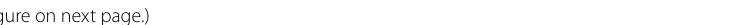
figure(See figure on next Fig. 1 Map of the focal area of the 2011 Tohoku-Oki earthquake. Focal mechanisms represent the mainshock (red), the aftershock in the off-Ibaraki (blue, hereafter “Ibaraki-Oki EQ”), and the aftershock in the off Iwate (green, hereafter “Iwate-Oki EQ”) estimated by NIED. Red squares denote the GEONET sites used for the primary analysis. Blue squares are the additional sites used for the analysis of the Iwate-Oki EQ. Gray rectangles show the assumed fault planes. Black and gray dotted lines indicate trench axis and the depth of the plate interface, respectively. Two red arrows in the bottom right corner indicate the direction of the assumed slip basis, which are oriented 25° from plate subduction denoted by the black arrow. Black squares indicate subfaults that are described in the following